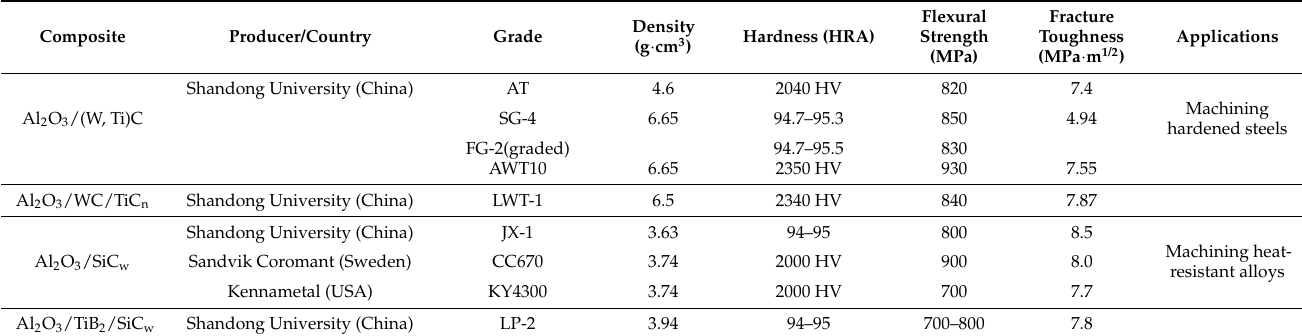
Table 2. Various categories, compositions, and properties of Al 2 O 3 -based ceramic instruments for turning hardened steels and heat-resistant